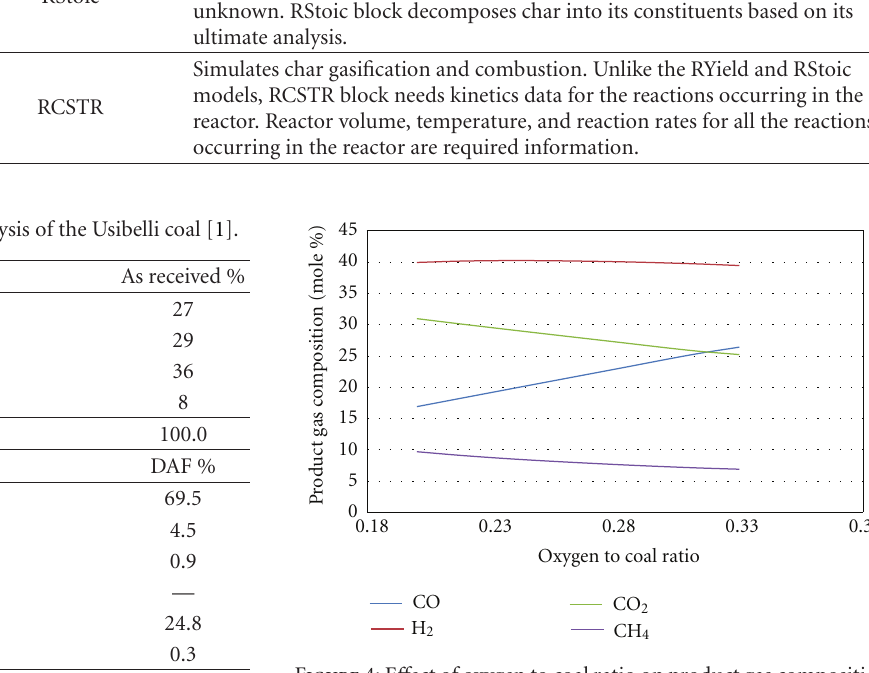
Figure 4: E ff ect of oxygen to coal ratio on product gas